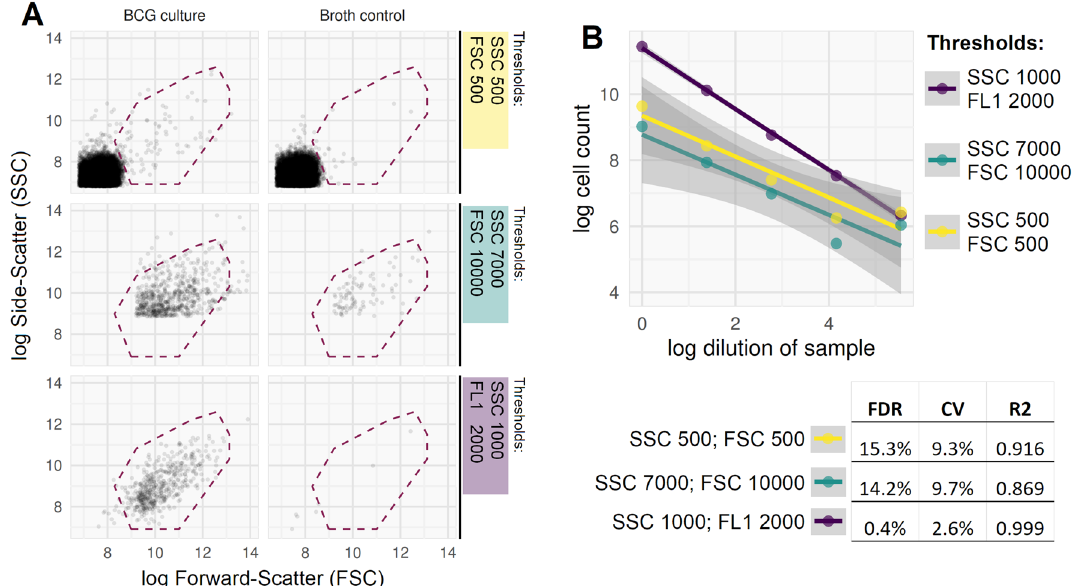
Figure 1. Comparison of 3 thresholding strategies in heat killed and SYBR-gold stained mid-log phase BCG broth culture. ( A ) Example FCM plots for three thresholding strategies (rows 1–3) applied to M. bovis BCG broth culture (column 1) and cell-free broth (cell-free negative control, column 2). Counts are extracted for the gated population (events within dashed red line), which is placed to maximise the count in BCG broth and minimise the count in the cell-free control. Recorded events in the low light scatter value thresholding (first row) are dominated by debris/noise, seen as a dense population with low SSC and FSC values in lower left quadrant; this is equally apparent in the cell-free control. Higher light scatter thresholding (second row) excludes these events, but still records a substantial portion of higher SSC/FSC noise (seen in cell-free control), and the threshold level appears to bisect the ‘real’ cell population; i.e. , losing cells from analysis. By contrast, the thresholding based on fluorescence (third row) is qualitatively better, with very few false positive events in the cell-free control, and detection of a discrete cell population in BCG broth which is not artificially bisected. ( B ) Greater internal consistency in the FL1/SSC thresholding strategy, with less error across serial dilutions of a M. bovis BCG culture. Quantitative evidence of improved absolute count validity includes a lower false discovery rate (FDR, defined as false positive cell count in cell-free control divided by paired cell count from broth); lower coefficient of variation (CV, calculated by standard deviation/mean from 5 technical replicates, averaged for 3 biological replicates); and higher R 2 from linear fit across serial dilution series (one biological replicate as shown in figure; p < 0.001 for F test comparing FL1/SCC to either FSC/SSC strategy; 95% confidence intervals for linear fit shown with grey shaded